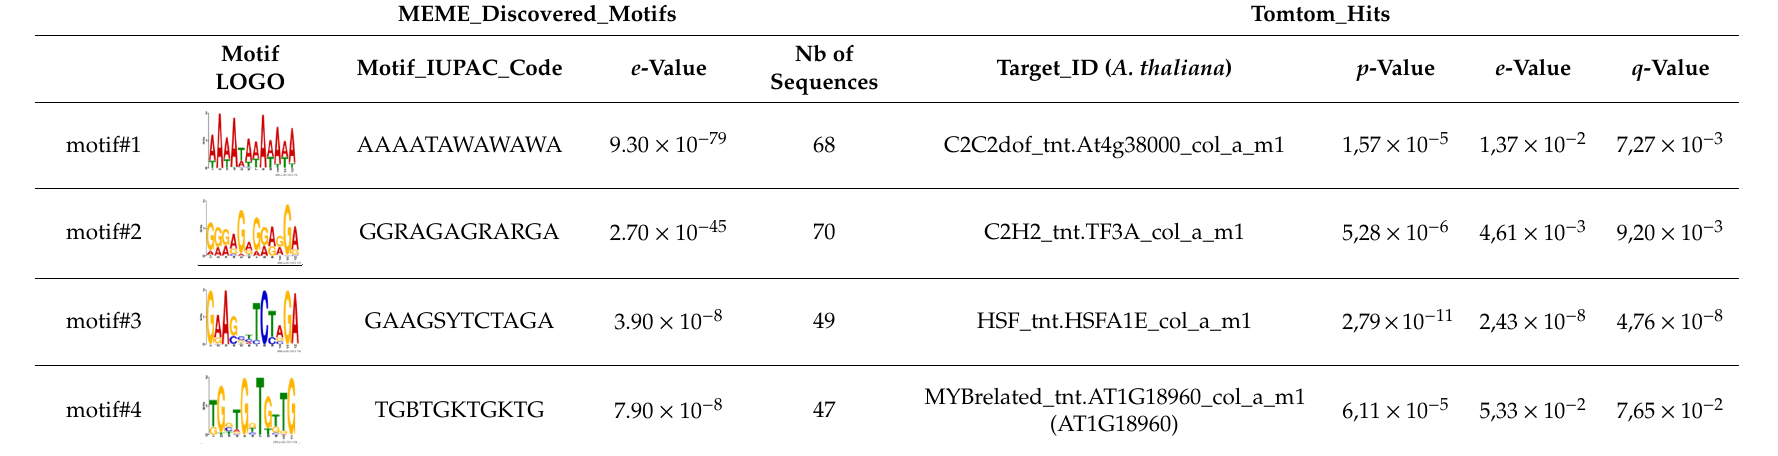
Table 1. MEME Suite discovered motifs within 1500 bp upstream from the initiation codon and Tomtom Hits of the top 100 genes in the yellow module form the WGCNA.